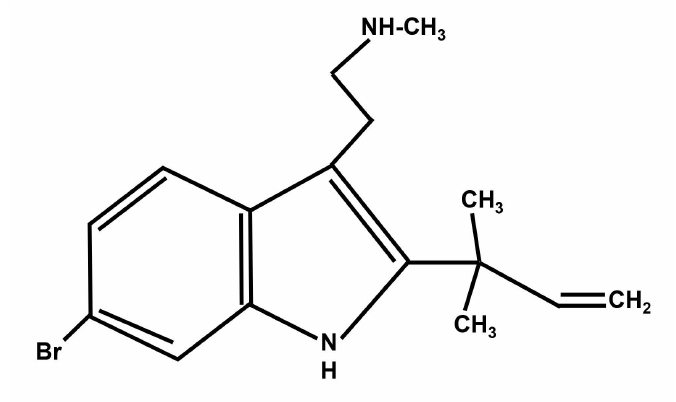
Figure 1. Structure of desformylflustrabromine